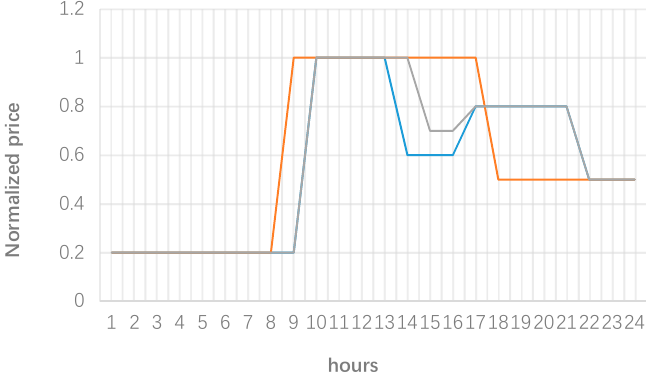
Figure 10. A typical time of use tariff for each cluster.